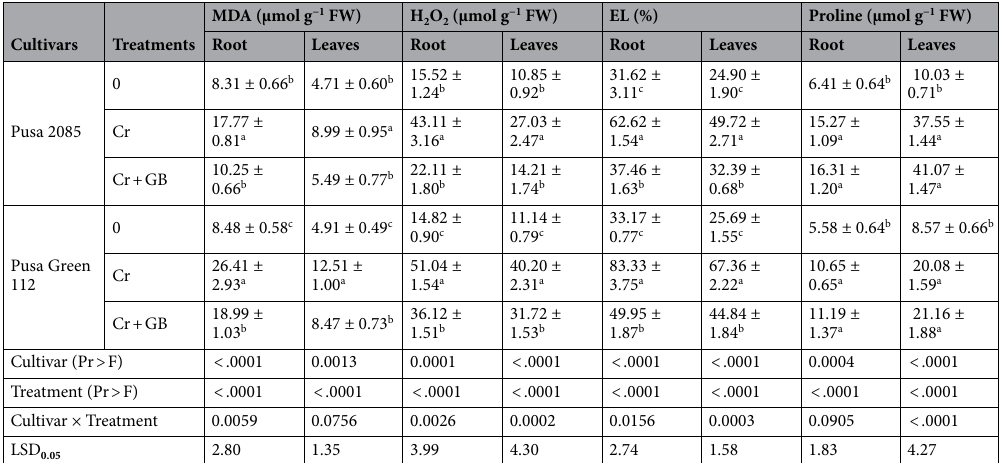
Table 1. Effects of different stress levels of glycine betaine (GB) and chromium (Cr) at 0 and 120 μM Cr and 120 μM Cr + 100 mM (GB) on malondialdehyde (MDA) levels, hydrogen peroxide (H 2 O 2 ) levels (μmol g −1 FW), electrolytic leakage (EL%), and proline levels (µmol g −1 FW) in the root and leaf tissues of both chickpea cultivars (Pusa 2085 and Pusa Green 112), at 42 days after sowing (grown in pots). The generated data values are shown as the mean of five replicates ± SE. The error bars indicated by the different letters represent significant differences, as tested by the least significant difference test (p < 0.05).